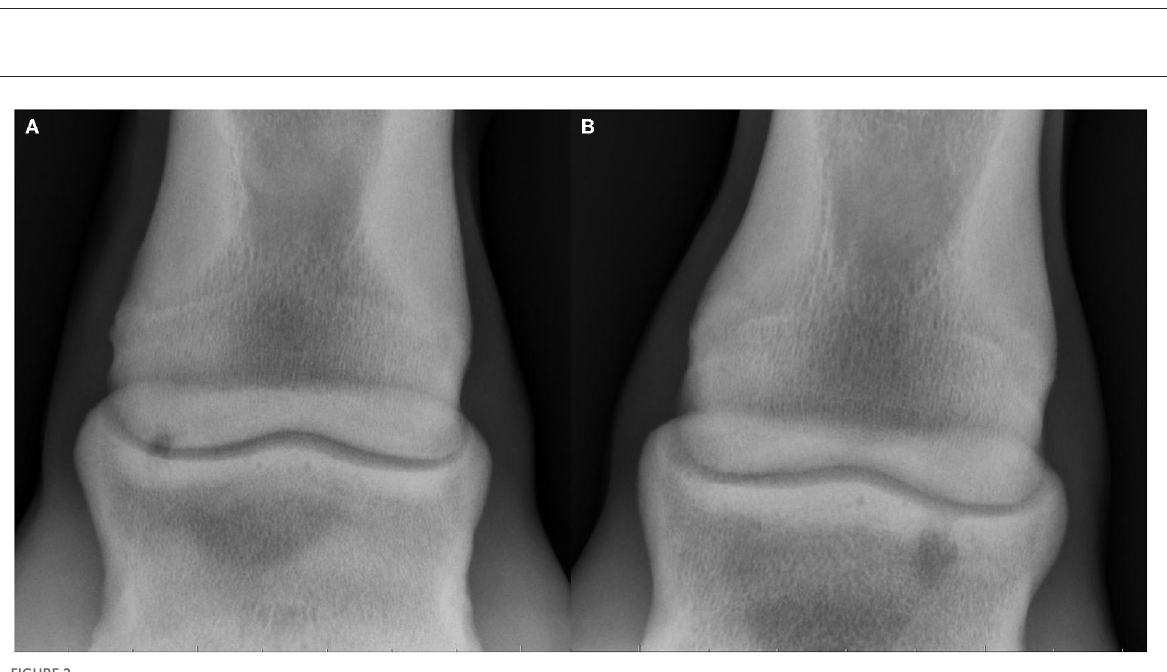
FIGURE2 Radiographs of subchondral lucencies at the proximal aspect of the middle phalanx (P2SC), lateral is oriented at the left of the images. (A) Dorsopalmar projection showing a well-defined shallow subchondral lucency in the proximolateral aspect of the middle phalanx (subtype 1). (B) Dorsoplantar projection showing a well-defined, ovoid subchondral lucency of the proximal aspect of the middle phalanx with surrounding zone of mildly increased sclerosis and a wide ill-defined cloaca extending proximally to the joint (subtype